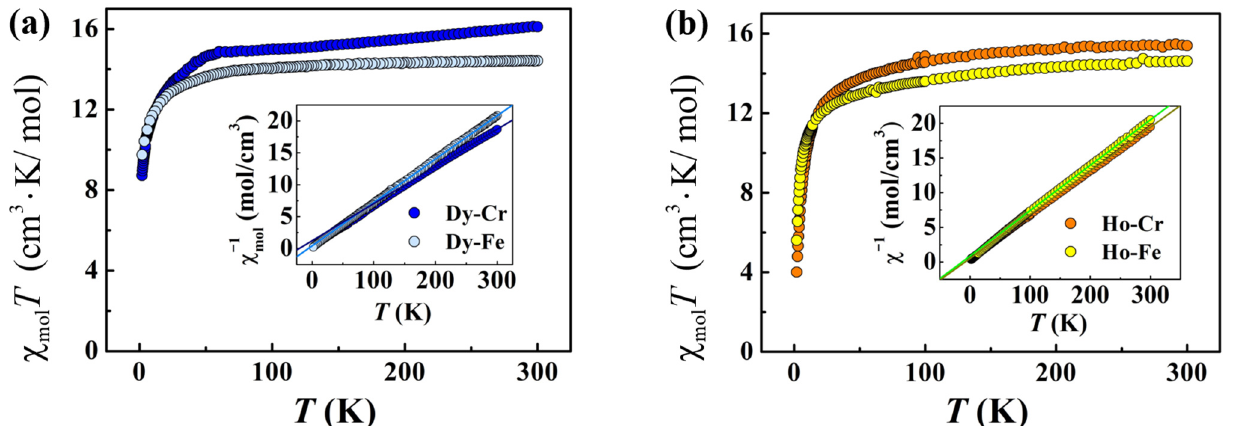
Figure 4. Temperature dependences of the χ T product for the complexes 1 DyCr , 2 DyFe ( a ) and 3 HoCr , 4 HoFe ( b ). The insets show the temperature dependences of inversed value of magnetic susceptibility with the linear approximations within 150–300 K temperature ranges, extrapolated to full scale of the temperature axis.